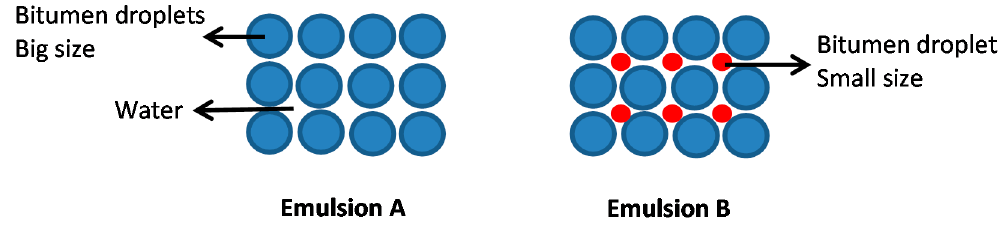
Figure 3. Schematic representation of a monomodal emulsion ( left ) and a bimodal emulsion ( right ).